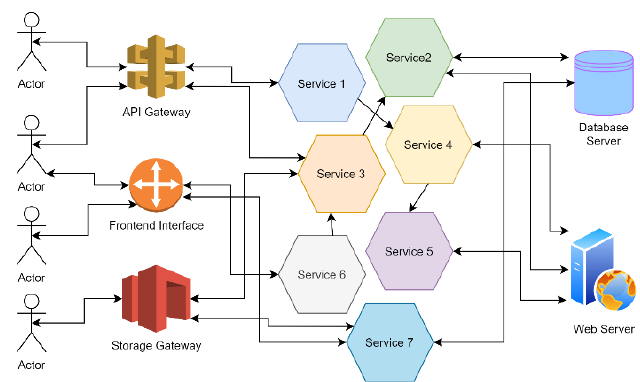
Figure 7. A fictitious microservice system. Figure 7. A microservice system